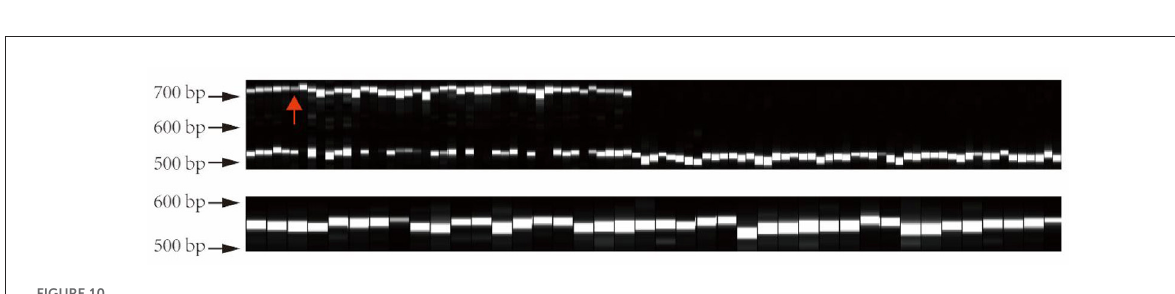
results comprehensively show that the OVATE gene family plays an important role in the growth and development of tea